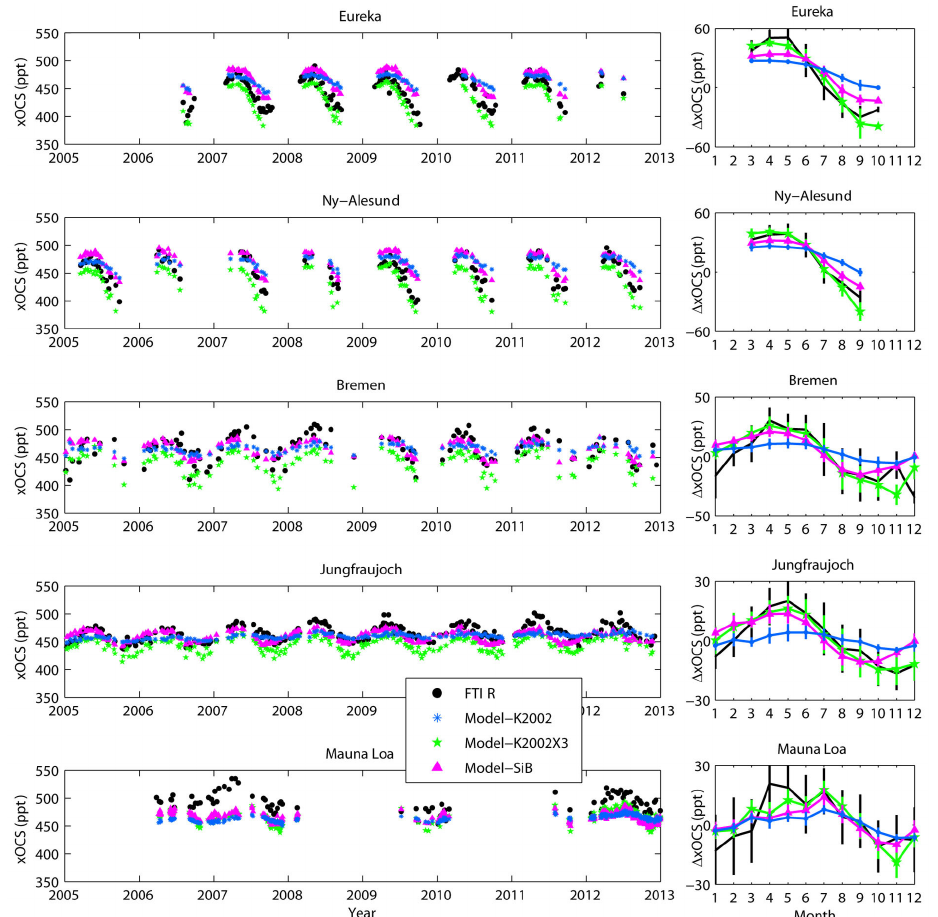
Figure 2. Comparison of FTIR measurements of OCS to model simulations at Eureka, Ny-Ålesund, Bremen, Jungfraujoch, and Mauna Loa. The left panels show weekly means from 2005 to 2012. The right panels are the monthly mean relative xOCS (relative to annual mean) averaged for multiple years. The error bars are the standard deviations of each month. The FTIR retrievals are shown by black dots. The model simulations are driven by K2002 (blue asterisks), K2002x3 (green stars), and SiB (magenta